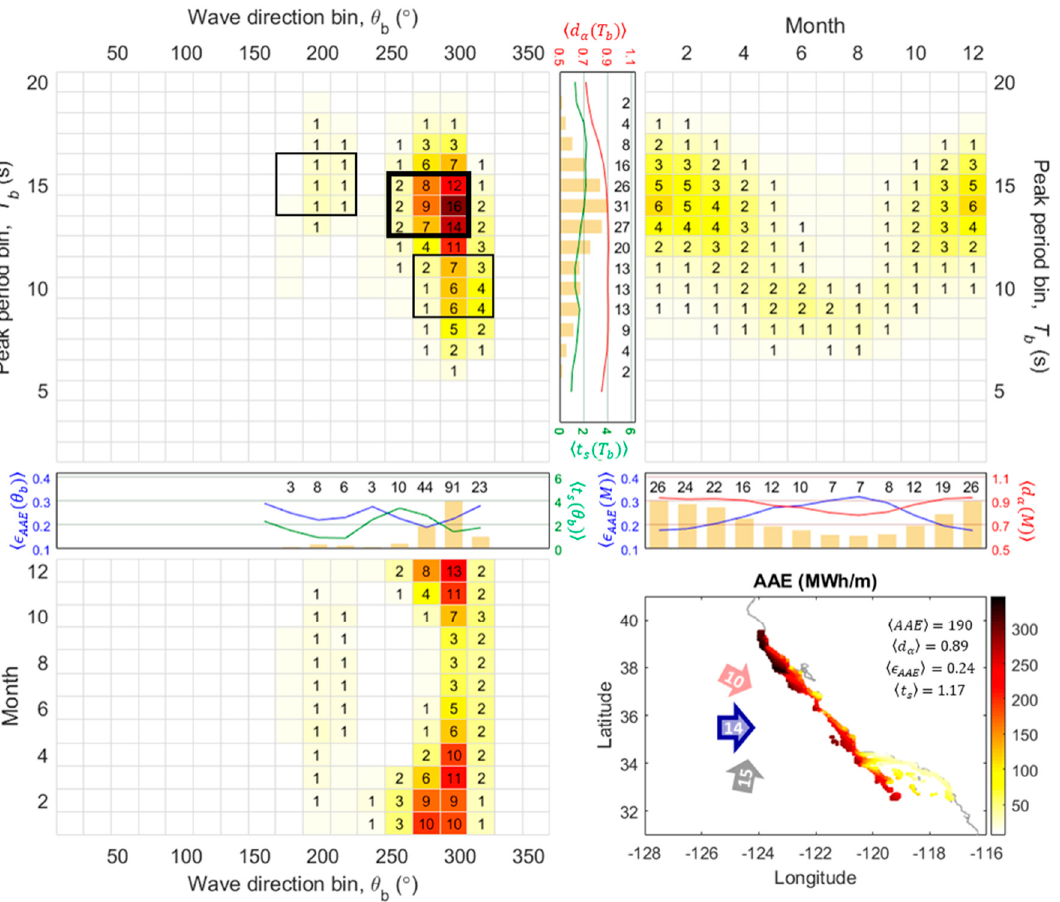
Figure 5. [Region 4: California Coast] The detailed descriptions are identical to Figure 2.